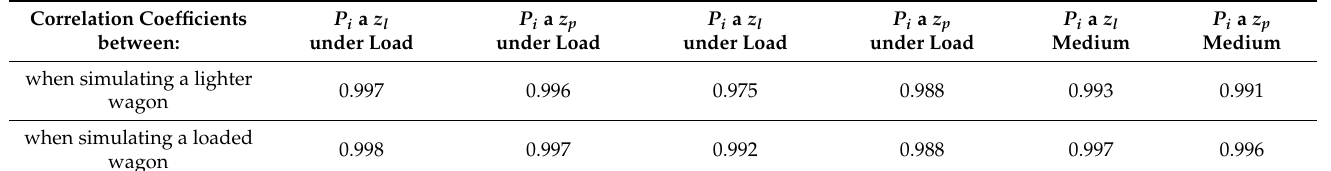
linear relationships. Straight lines were found to best describe the force-displacement relationships. The results relating to the left rail are shown in Figure 5. Table 4. Correlation coefficients. Table 4. Correlation coefficients.